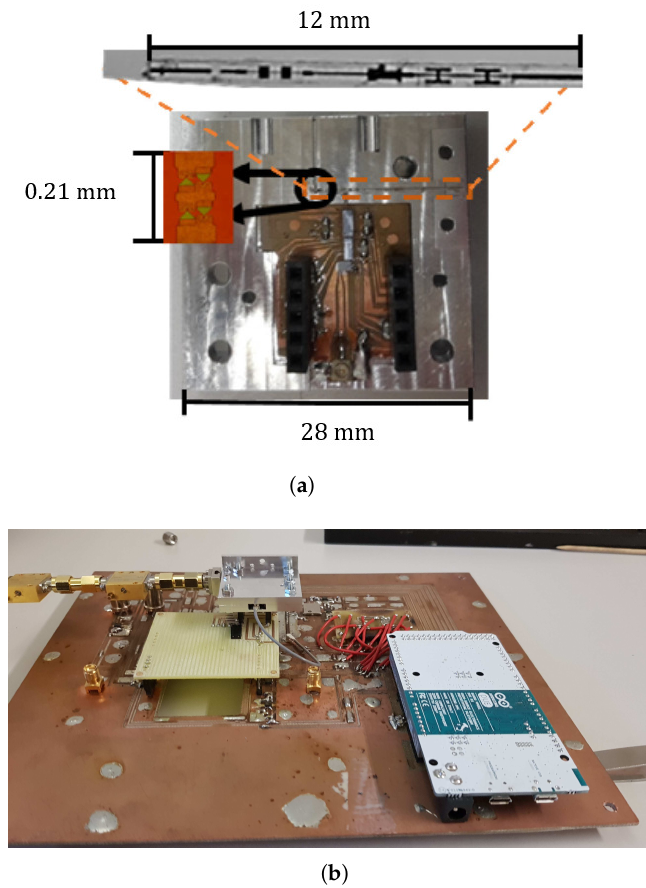
Figure 4. Photographs of ( a ) top view of the subharmonic mixer and local oscillator in the metallic block; ( b ) measurement setup for the fourth-harmonic mixer